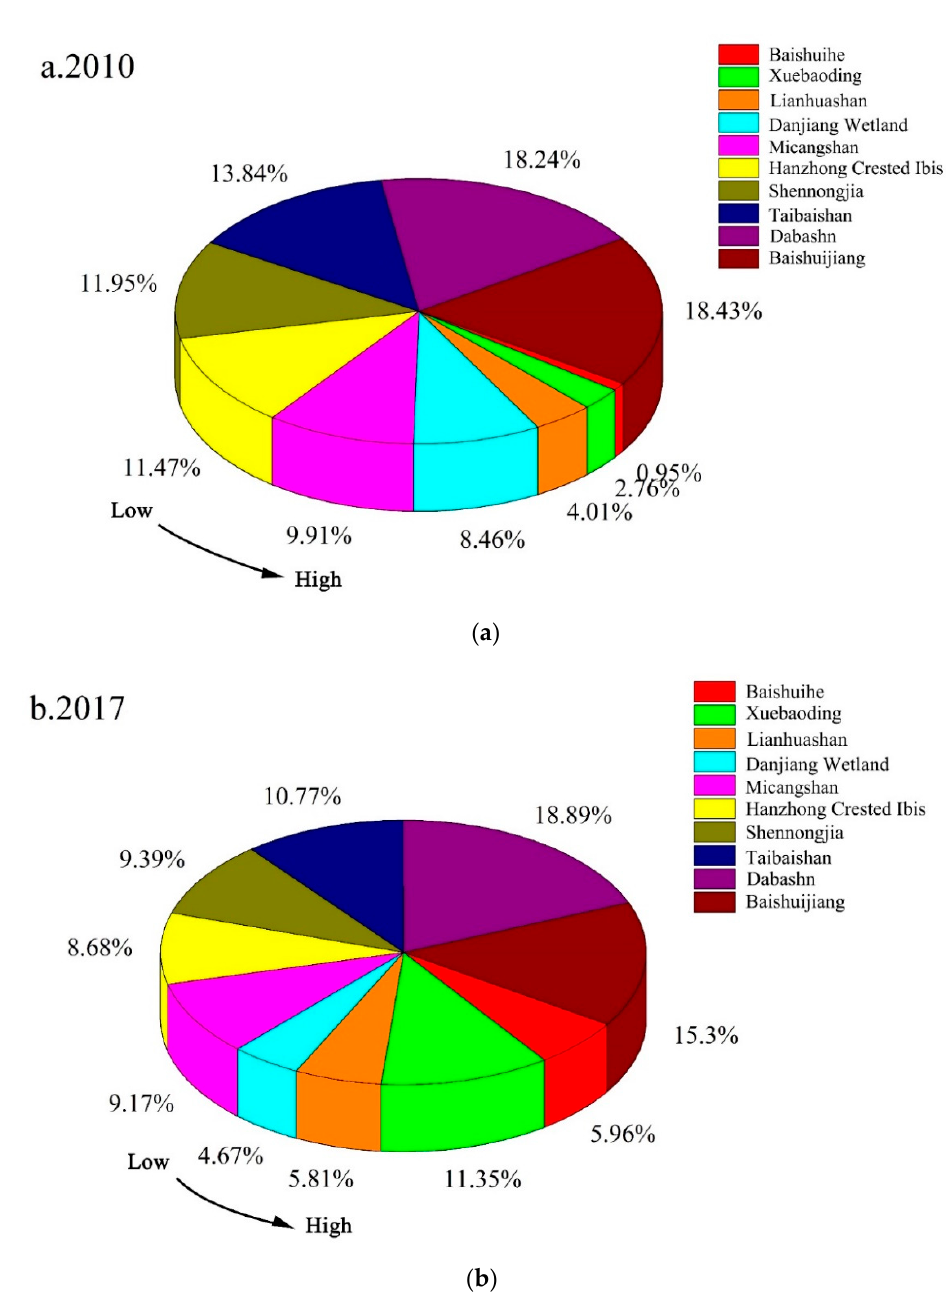
Figure 3. Proportion of the comprehensive variable scores of the landscape patch index in 2010 ( a ) and 2017 ( b ).